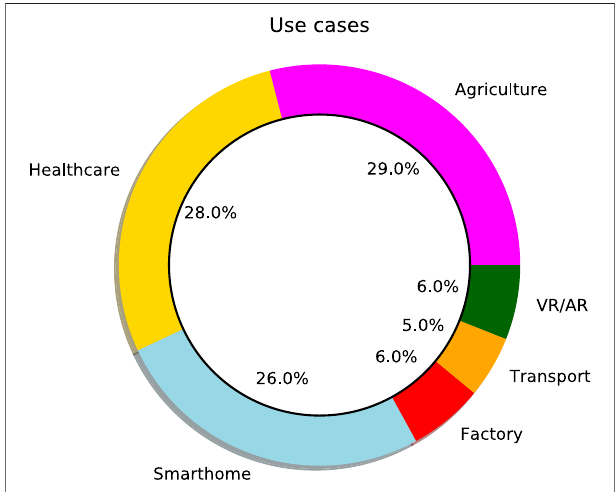
FIGURE 4 | Trend of United Kingdom towards the fi fth generation of cellular networks